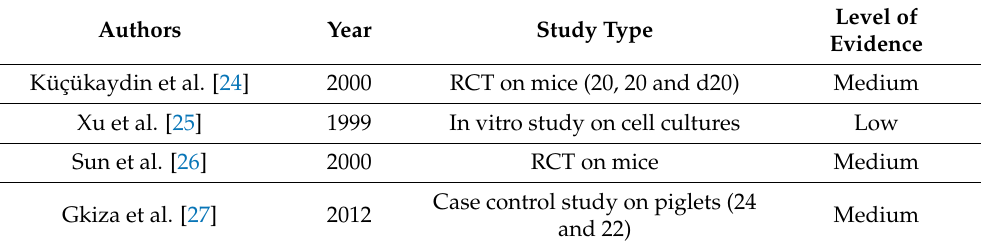
Table A2. Intestinal barrier function and I/R